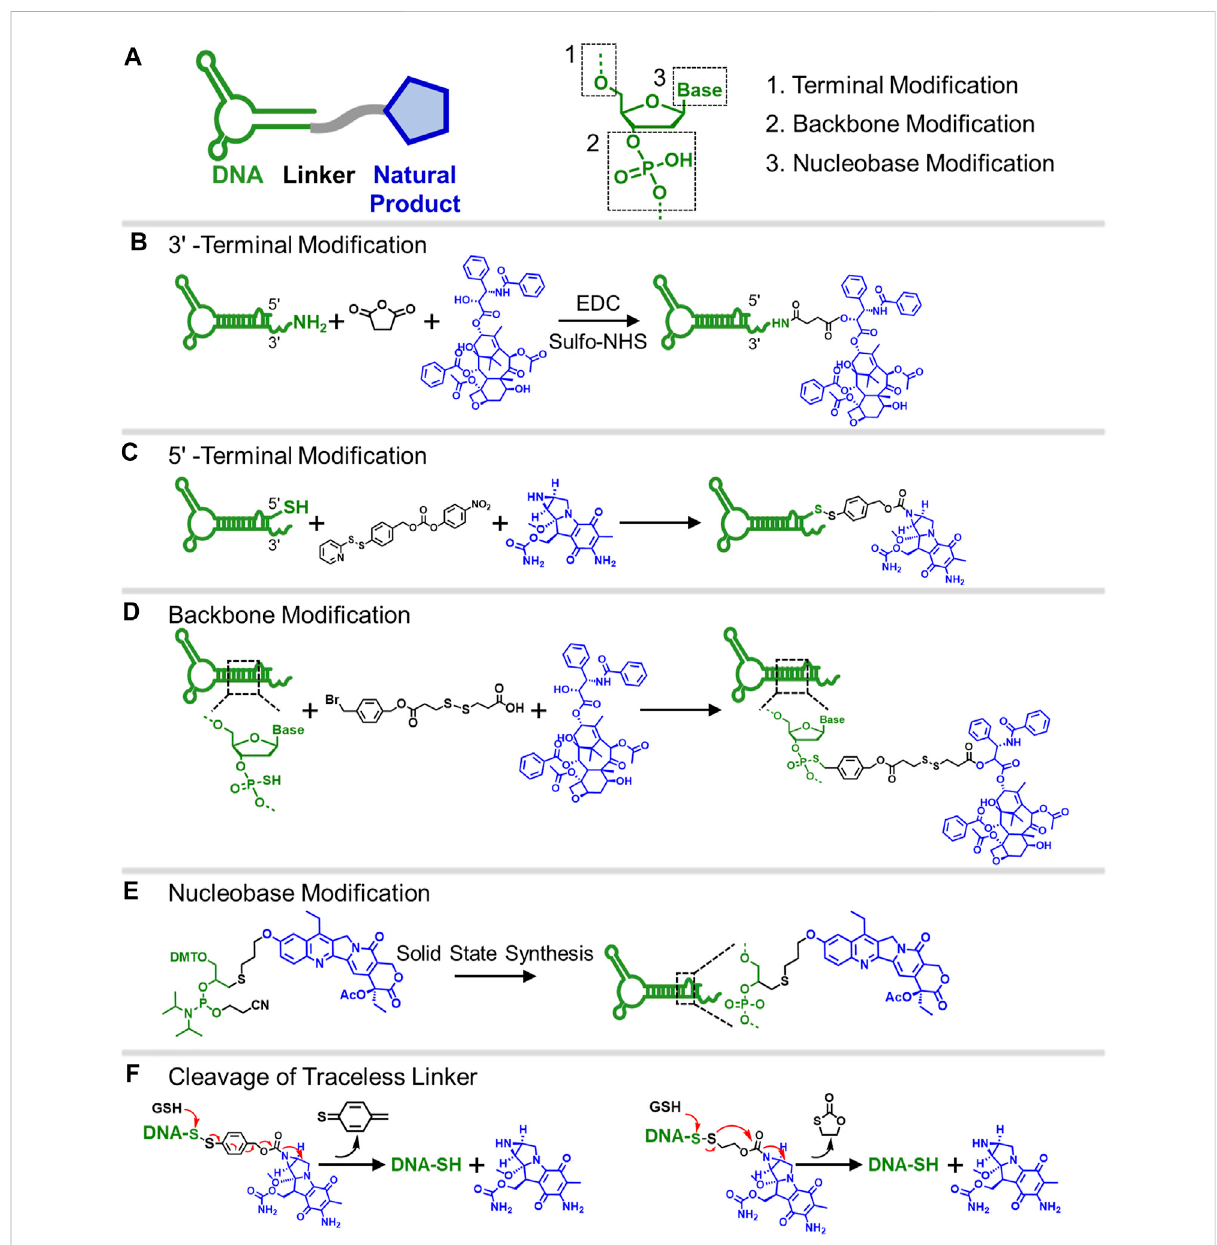
FIGURE 1 (A) Scheme showing the “ ligand-linker-drug ” construct and three commonly used modi fi cation sites on a DNA nucleotide for conjugation. (B) Conjugation of PTX on 3 ′ -terminus of an amine-modi fi ed DNA. (C) Conjugation of MMC on 5 ′ -terminus of a thiolated DNA. (D) Conjugation of PTX on phosphorothioate backbone using a hetero-bifunctional linker. (E) Use CPT-containing phosphoramidite to prepare a drug-loaded aptamer strandusingsolid-statesynthesis. (F) Twocommonlyusedtracelesslinkerstoenablethereleaseofnativenaturalproductdrugsinthepresence of